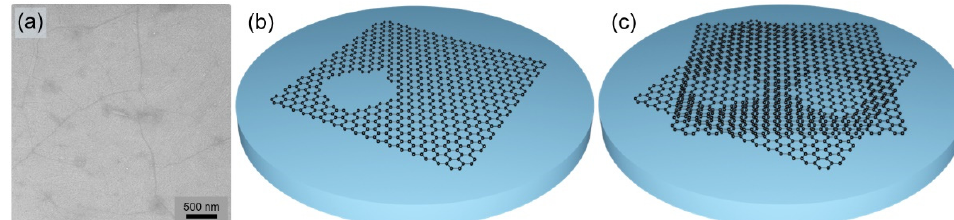
Figure 1. SEM image of monolayer graphene after the transfer procedure ( a ). Illustration of the hole in monolayer graphene ( b ), and of the holes covered by each of two overlapping graphene monolayers ( c ).